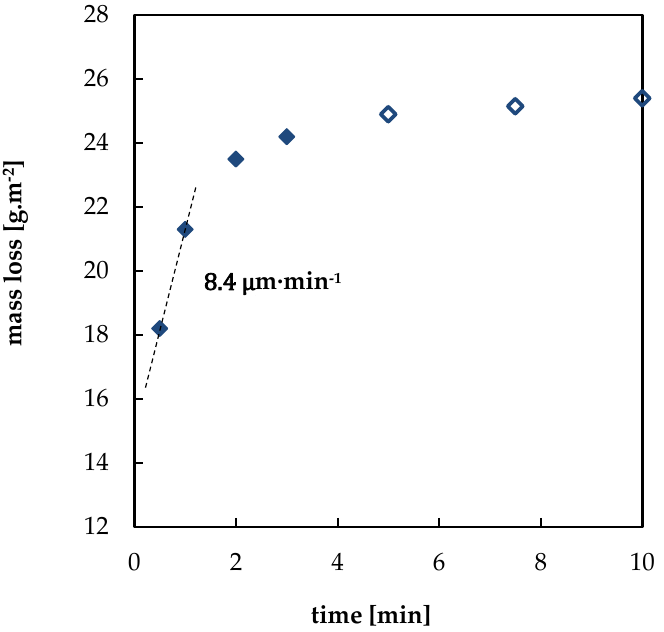
Figure 5. Determination of the rate of corrosion products dissolution (dashed line) for a specimen with acetate corrosion products in saturated ammonium acetate solution; (cid:169) dissolution of corrosion products; ♦ dissolution of metallic lead. Table 4. Dissolution rate of model corrosion products in tested solutions.